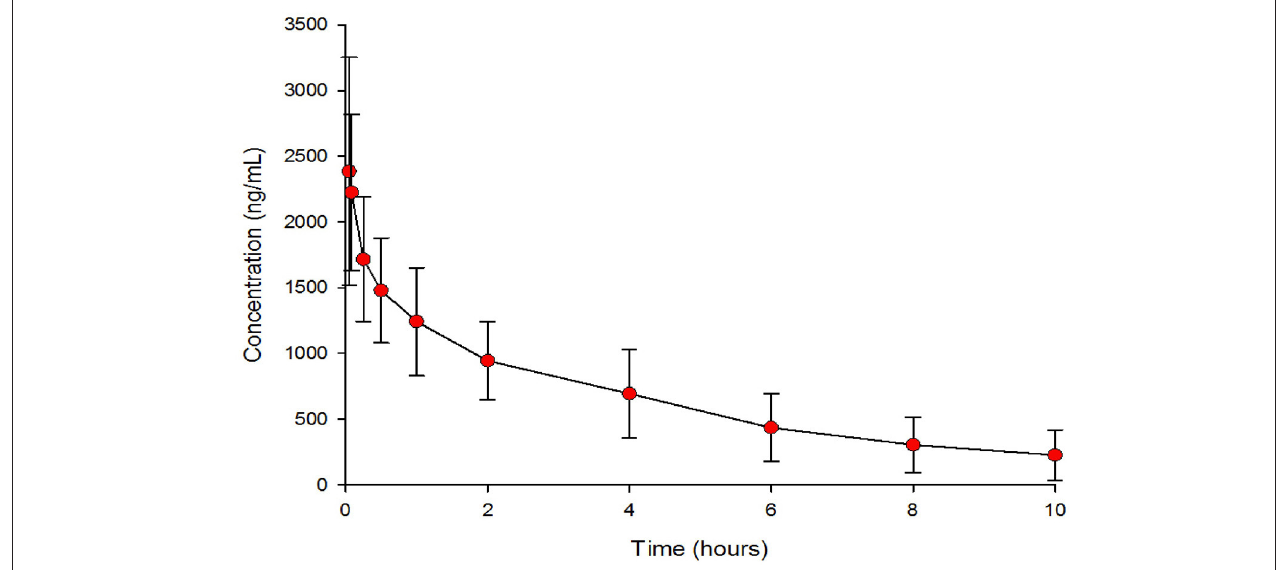
FIGURE 1 | Esomeprazole plasma concentration after intravenous administrations of 40mg dose age.